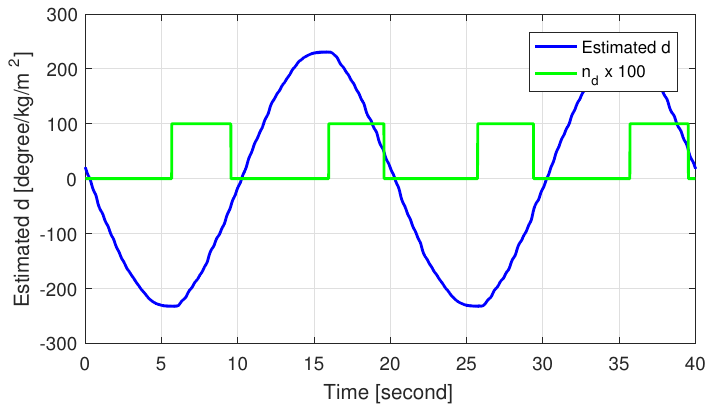
Figure 7. Estimated self-aligning torque in case 2.